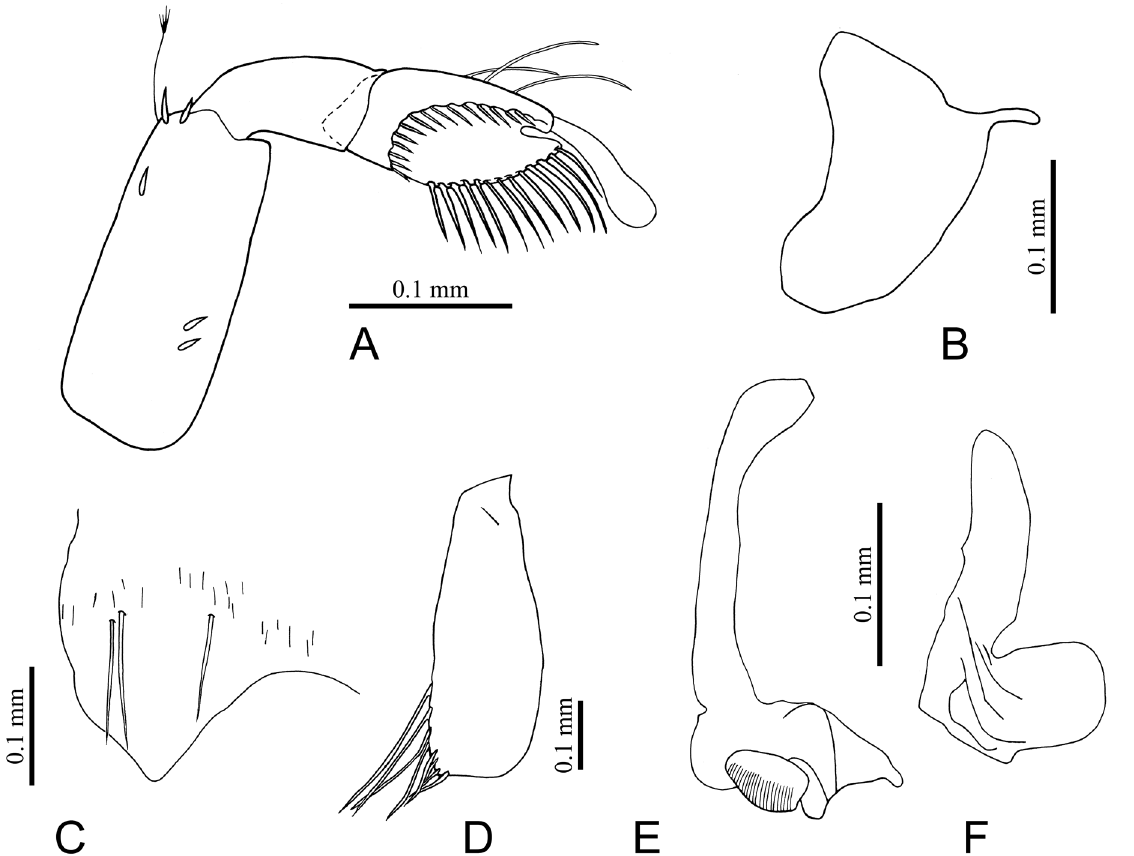
Fig. 15. Morphological features of Micronecta clavata sp. nov., ♂, paratype (ZVNU). A . Fore leg. B . Prestrigilar flap. C . Median lobe of sternite VII. D . Free lobe. E . Right paramere. F . Left